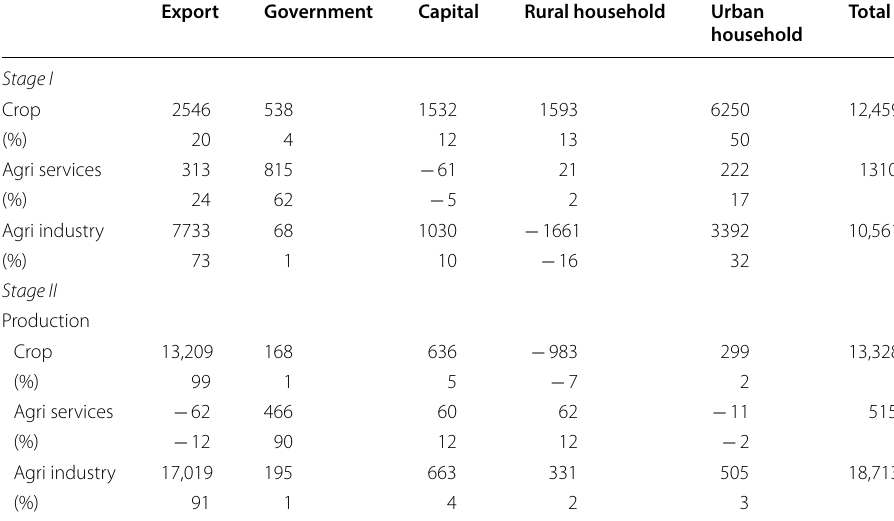
Unit : million Chinese